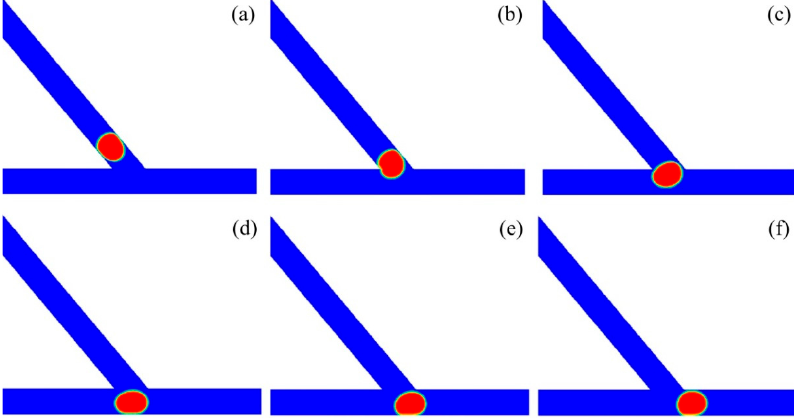
Figure 6. Passive sorting of small droplet into the right channel ( θ = 50°, U = 20 mm/s, V d /w 3 = 0.6). ( a ) T0, ( b ) T1 = T0 + 0.6, ( c ) T2 = T0 + 1, ( d ) T3 = T0 + 1.6, ( e ) T4 = T0 + 2.8, ( f ) T5 = T0 + 3.6.